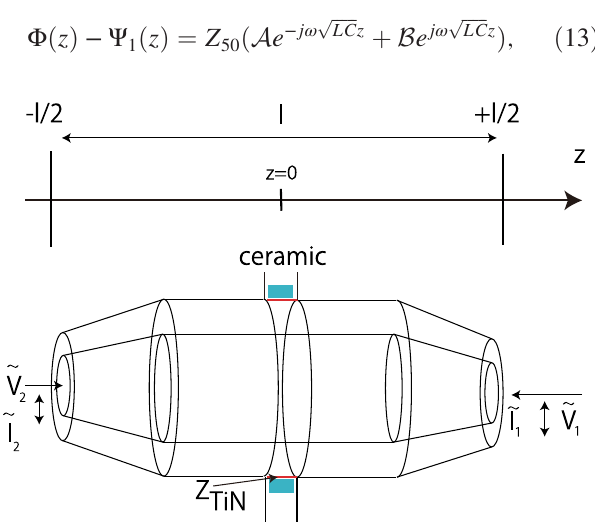
FIG. 5. Measurement setup for observing the beam impedance Z or the electric impedance Z cerTiN ;L